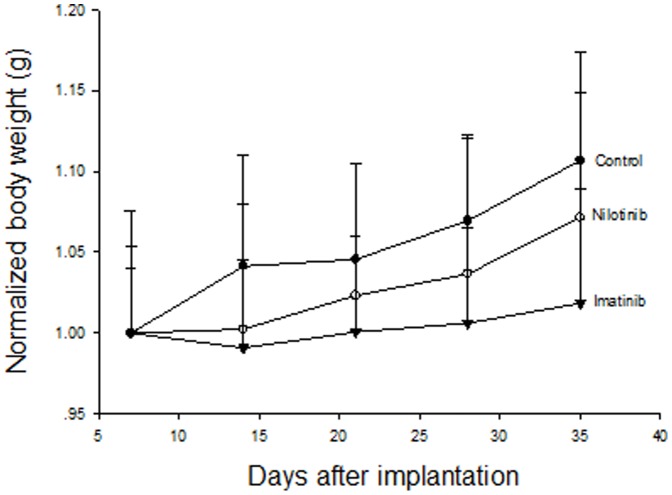
Change of body weights of mice in the three groups over whole experiment period of 35 days.Standard deviations are shown in single direction.